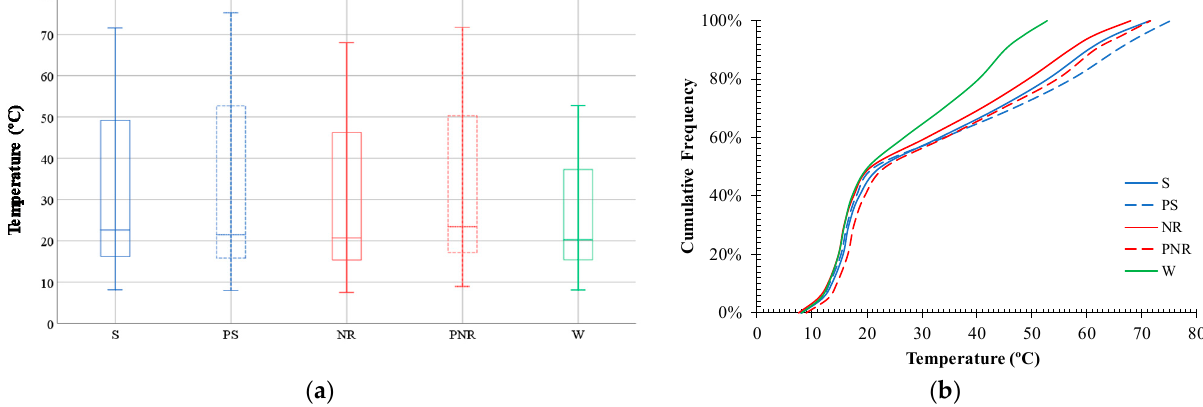
Figure 10. Surface temperature during a mild week (M12): ( a ) Box-plots; ( b ) Cumulative frequencies.